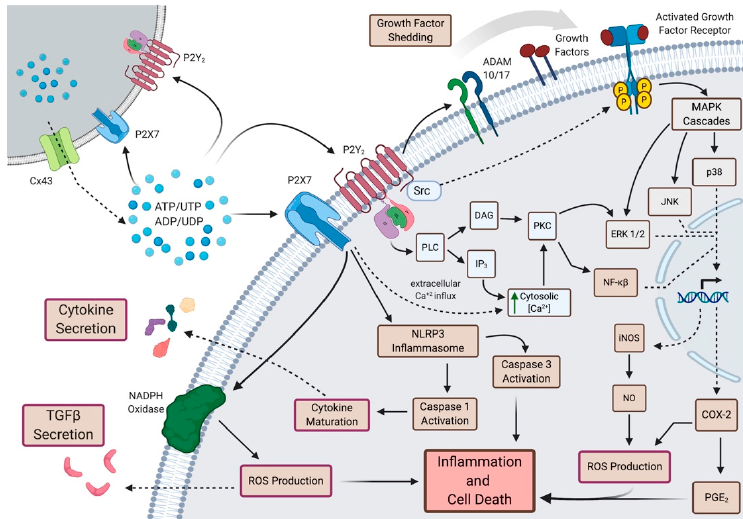
Figure 3. Purinergic Signaling in Bystander Effects. In response to elevated extracellular ATP (eATP) levels following irradiation, P2Y 2 R and P2X7R, which are expressed in murine and human salivary glands, may mediate a number of bystander effects. Through activation of the NLRP3 inflammasome, P2X7Rs promote ROS production, growth factor maturation (e.g. , IL-1 β ) and subsequent release and apoptosis. Activation of either P2Y 2 R or P2X7R causes increased [Ca 2+ ] i and subsequent downstream signaling processes (e.g. , ERK1/2 signaling, gene expression changes, inflammatory processes). P2Y 2 R activates phospholipase C (PLC) resulting in the production of inositol 1,4,5 trisphosphate (IP 3 ) and diacylglycerol (DAG), in turn mobilizing intracellular Ca 2+ and activating protein kinase C (PKC), respectively, and subsequent downstream signaling. Through its C-terminal Src-homology 3 (SH3) domain, the P2Y 2 R is involved in Src-dependent activation of growth factor receptors (e.g., EGFR, VEGFR-2) and downstream MAPK signaling as well as transactivation of EGFRs through activation of metalloproteases, ADAM10 and ADAM17. P2Y 2 Rs may also contribute to the bystander effect by promoting latent TGF- β signaling. DAG: diacylglycerol; PLC: phospholipase C; PKC: protein kinase C; ERK: extracellular signal-regulated protein kinase; JNK: c-Jun N-terminal kinase; MAPK: mitogen-activated protein kinase; COX: cyclooxygenase; PGE 2 : prostaglandin E 2 ; ADAM: A Disintegrin And Metalloprotease. Created with Biorender.com.